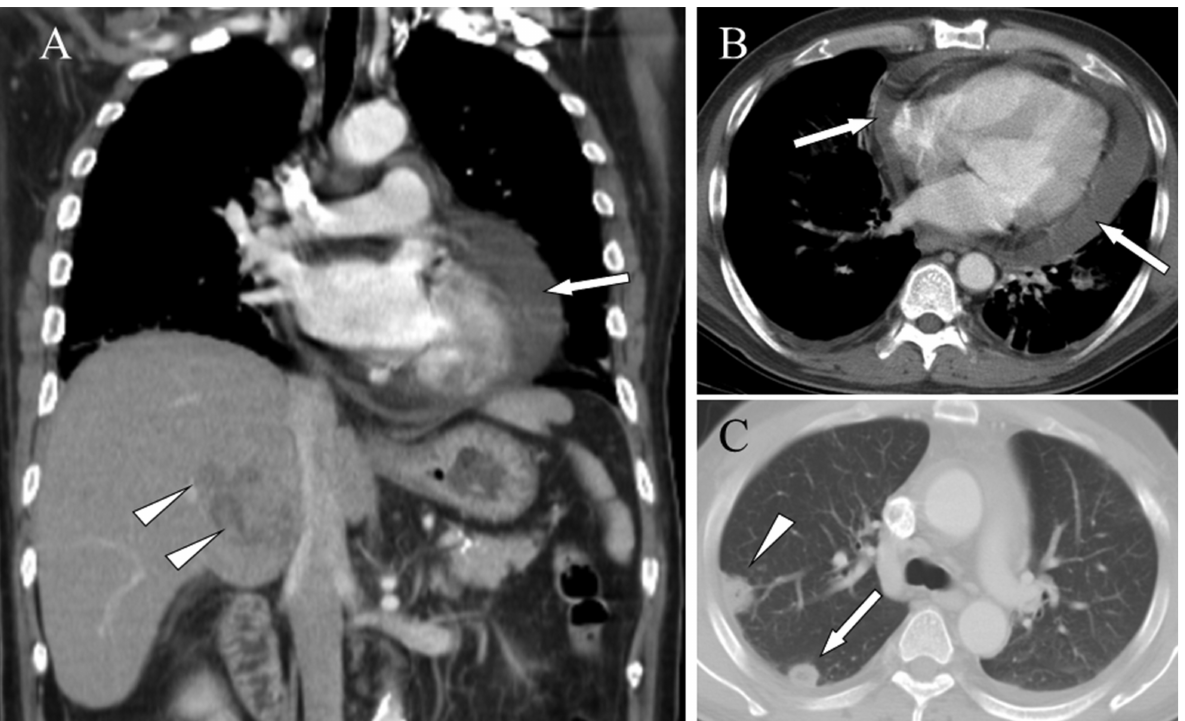
Figure 5 - Pericardial effusion and septic pulmonary embolism caused by a Klebsiella pneumoniae liver abscess in a 73-year-old woman. A) A mediastinum window of a coronal computed tomography scan reveals a hypodense, hypovascular mass of approximately 5 cm in diameter in the S7 area of the right hepatic lobe (arrowheads) and fluid in the pericardial space (arrow). B) A mediastinum window of a cross-sectional computed tomography scan shows fluid in the pericardial space (arrows). C) A lung window of a cross-sectional computed tomography scan shows a peripheral wedge-shaped (arrowhead) and a peripheral nodular (arrow)